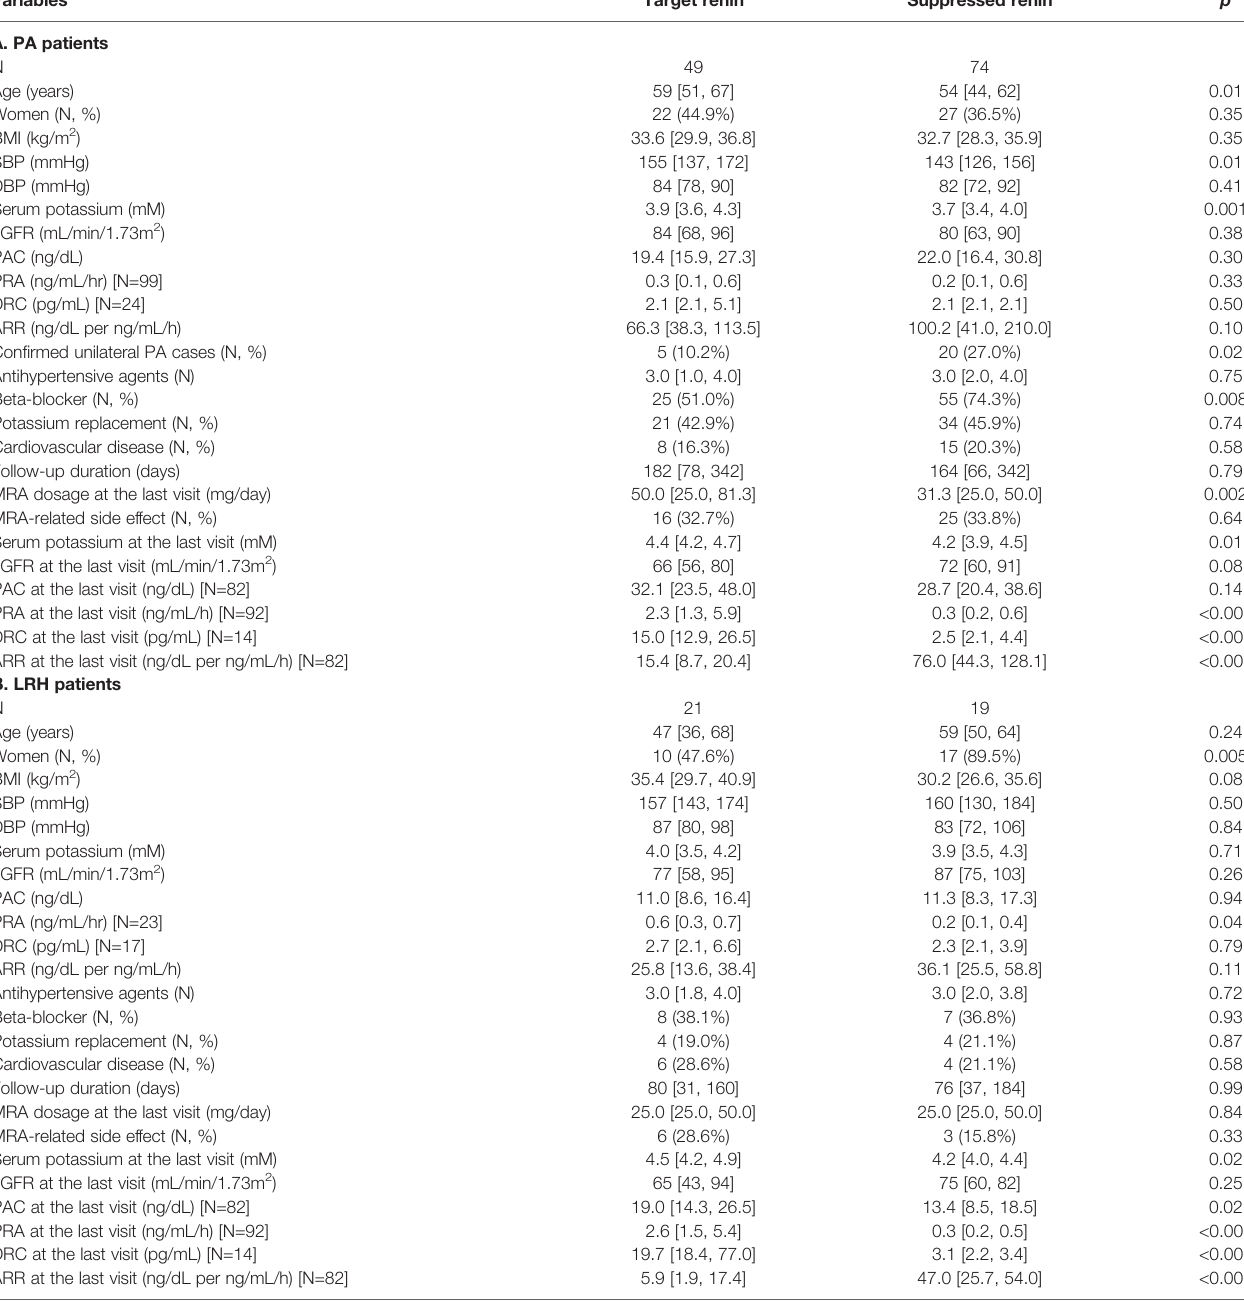
TABLE 2 | Comparison of patients with and without target renin following MRA